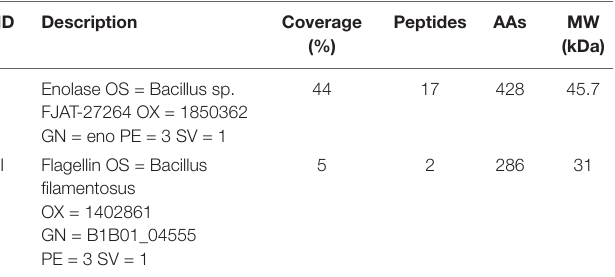
TABLE 3 | Identification by MS of fragments purified from denaturing 2D gel electrophoresis ( Figure 4